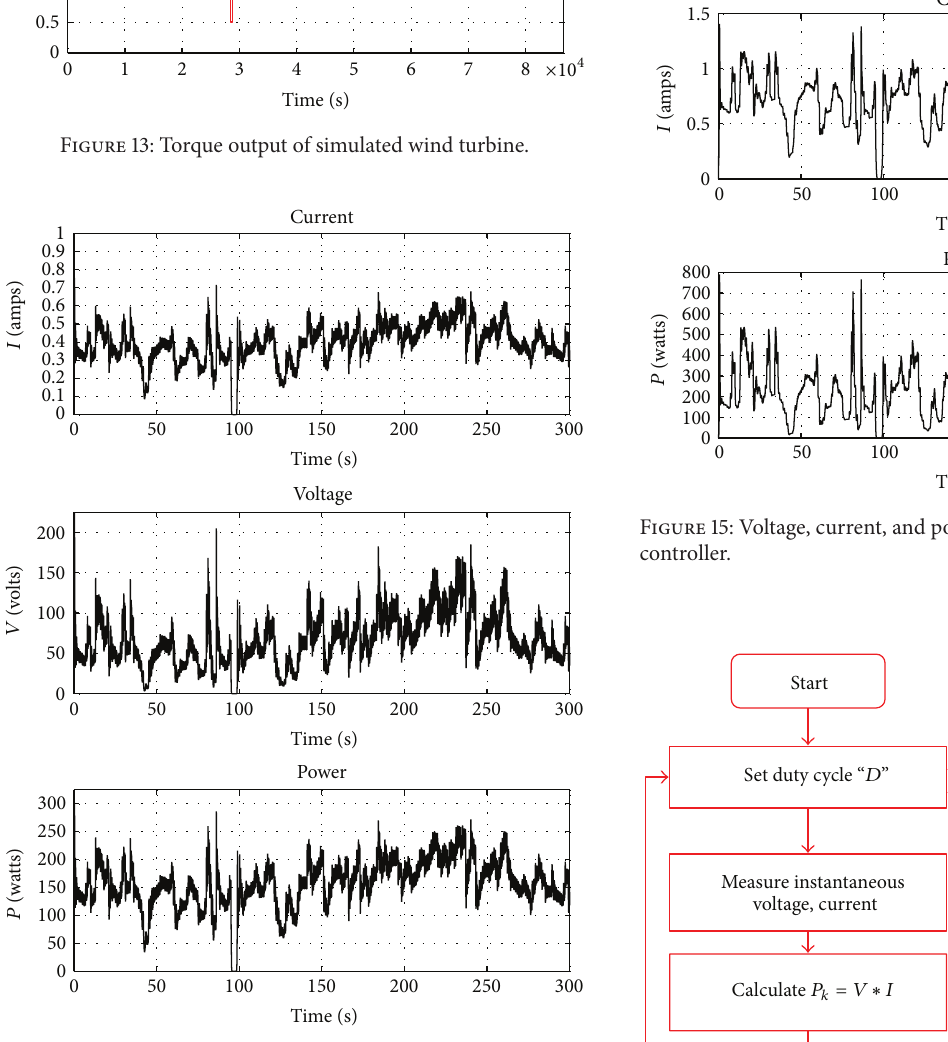
Figure 14: Voltage, current, and power output of WTG without MPPT controller.